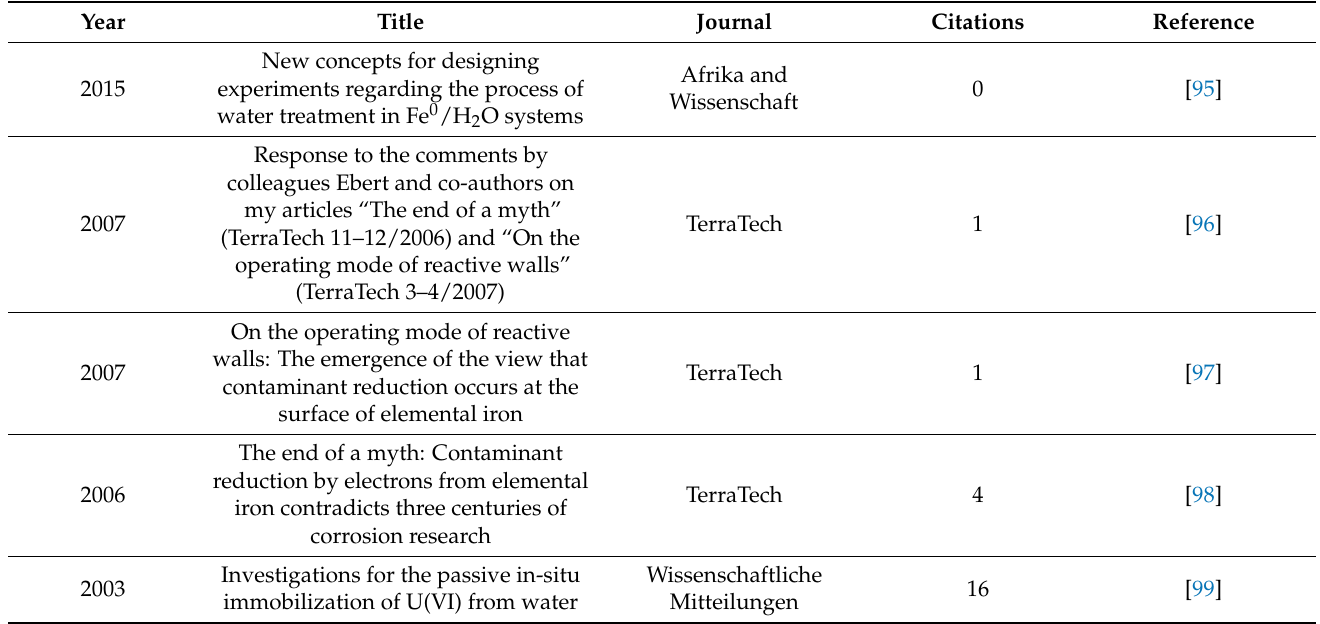
Table 3. The five articles in German (‘German papers’) refuting the reductive transformation concept and their citations according to Google Scholar (accessed on 31 August 2022). The original titles are given in the